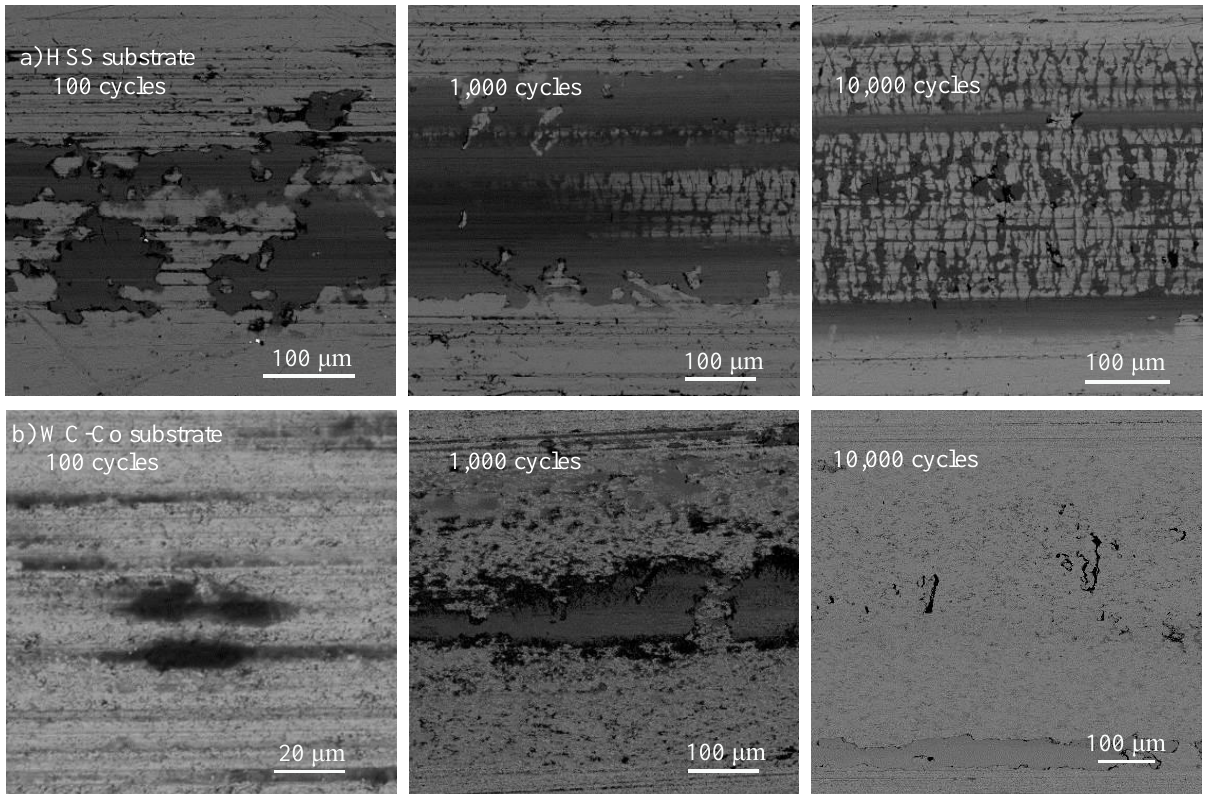
Figure 8. Wear process of uncoated samples: ( a ) HSS ; ( b ) WC-Co.